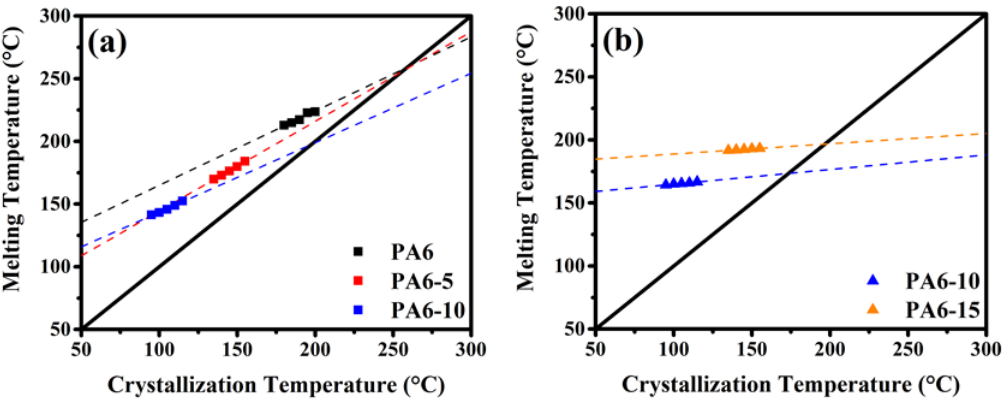
Figure 2. The melting temperatures at different isothermal processes for ( a ) pure PA6, ( b ) PA6-5, ( c ) PA6-10, and ( d ) PA6-15.